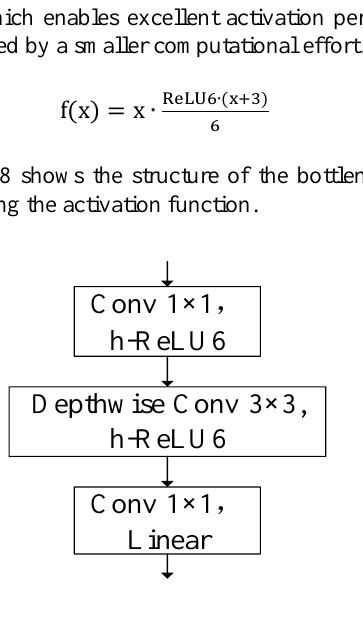
Figure 8. Replace the activated